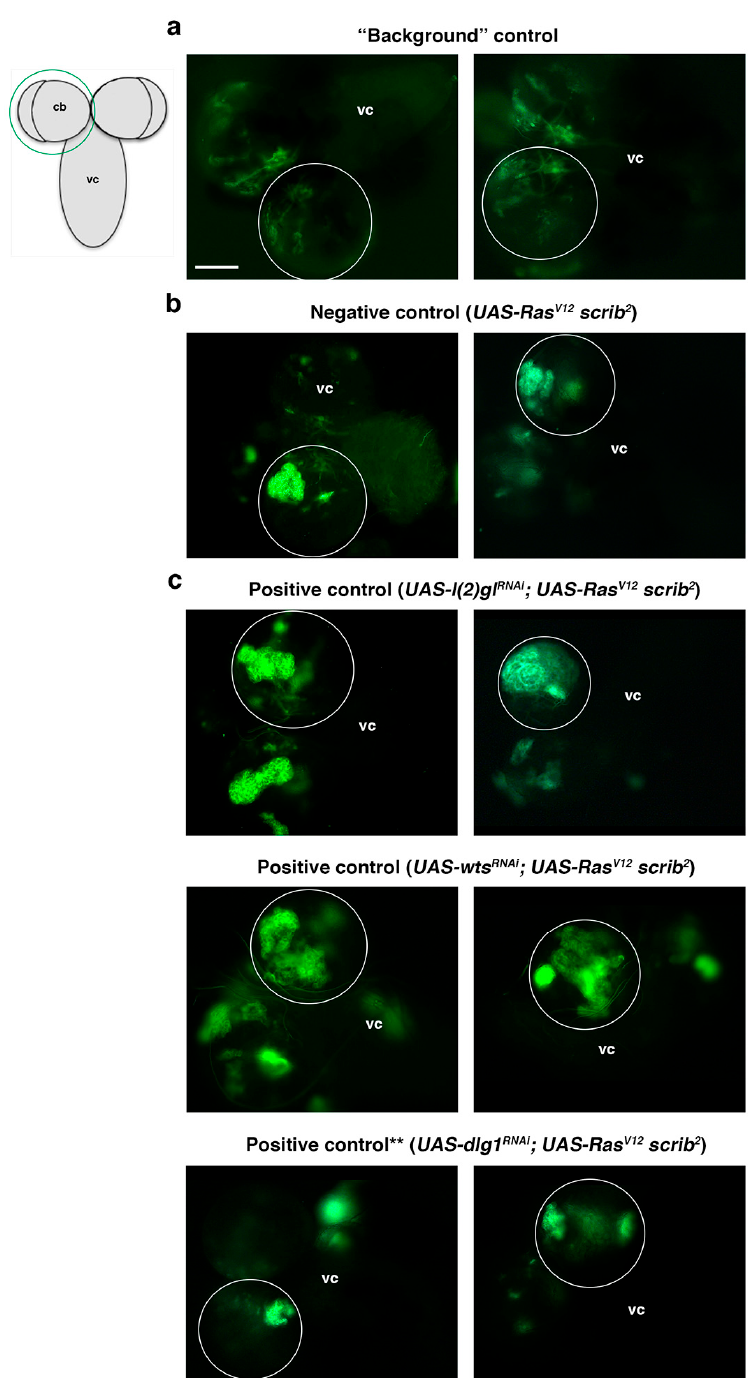
Figure 4. Screen controls. All panels show a dorsal view of a larval CNS that includes the ventral cord (vc) and the two brain hemispheres, one of which is encircled, as represented in the schematic larval CNS; cb (central brain). ( a ) A background control in which the GFP detected is leaky GFP or autofluorescence, as the Gal80 repressor is present to inhibit the CD8::GFP expression driven by the Gal4 line (see also Figure 3). ( b ) Two examples of the biggest Ras V 12 scrib 2 NBII clones found, which is our established “negative control” (i.e., not considered TLO). Clones in the experimental lines above that size are considered TLO and potential “positive lines.” ( c ) Positive controls, which are known ACD regulators, including l(2)gl and wts , whose downregulation in Ras V 12 scrib 2 NBII clones induce TLO; (**) The downregulation of dlg1 , another potential positive control, in Ras V 12 scrib 2 NBII clones does not show clear TLO when tested under the conditions of the screen workflow (see also text and Table 1). Scale bar: 100 µ m for all